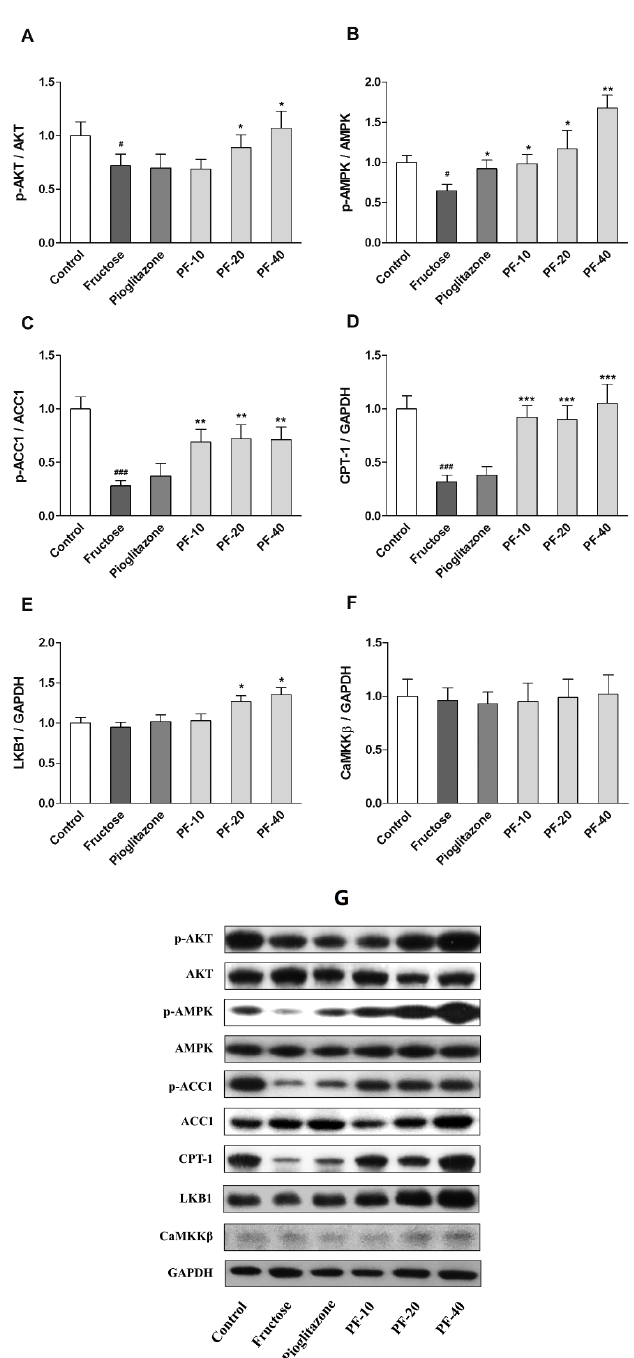
Figure 5. Effects of paeoniflorin on the body weight and insulin sensitivity in rats. ( A ) The phosphorylation level of AKT. ( B ) The phosphorylation level of AMP-activated protein kinase (AMPK). ( C ) The phosphorylation level of ACC1. ( D ) The protein expression of CPT-1. ( E ) The protein expression of LKB1. ( F ) The protein expression of CaMKK β . ( G ) Immunoblot bands. Data were normalized by the abundance of GAPDH and expressed as the relative value to control. Data were expressed as the mean ± SEM ( n = 6) and analyzed by one-way ANOVA followed by Dunnett’s post hoc test. # p < 0.05 and ### p < 0.001 vs. control group. * p < 0.05, ** p < 0.01 and *** p < 0.001 vs. fructose group. PF-10: 10 mg/kg of paeoniflorin; PF-20: 20 mg/kg of paeoniflorin; PF-40: 40 mg/kg of paeoniflorin; AKT: Protein kinase B; AMPK: AMP-activated protein kinase; ACC1: Acetyl coenzyme A carboxylase; CPT-1: Carnitine palmitoyltransferase I; GAPDH: Glyceraldehyde-3-phosphate dehydrogenase; LKB1: Tumor suppressor serine/threonine kinase 1; CaMKK β : Ca 2+ /CaM-dependent protein kinase kinase β